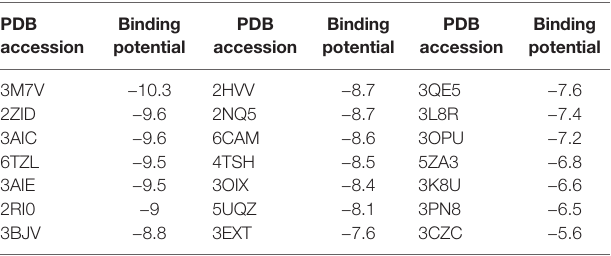
TABLE 2 | Binding potential with selected proteins